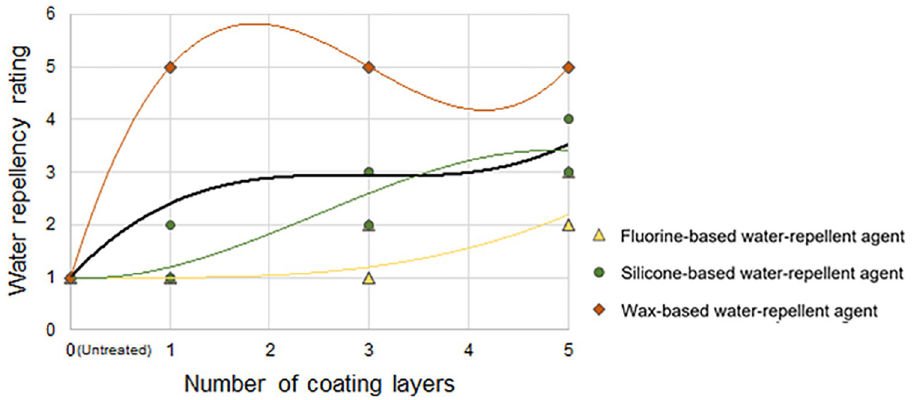
Fig 9. Water repellency of the cotton woven fabric according to the number of coating layers of the water- repellent agent. The black line represents the trendline (third-order polynomial).